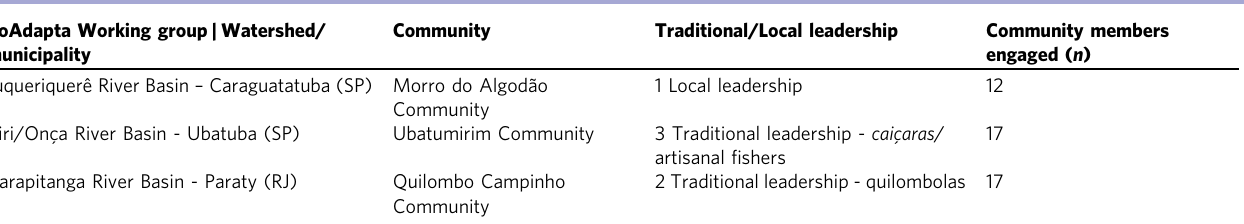
Table 1 CoAdapta working groups (WGs) to participatory action